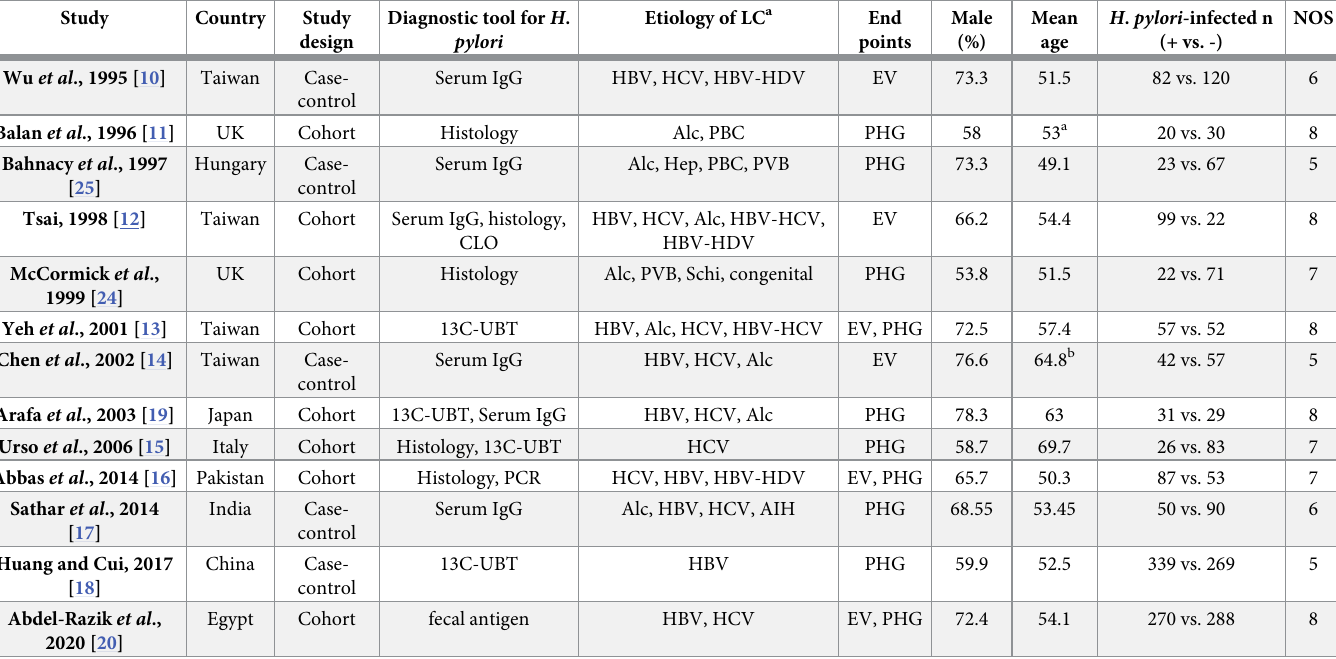
Table 1. Main characteristics of all studies in the meta-analysis (ordered by publication year and study design).